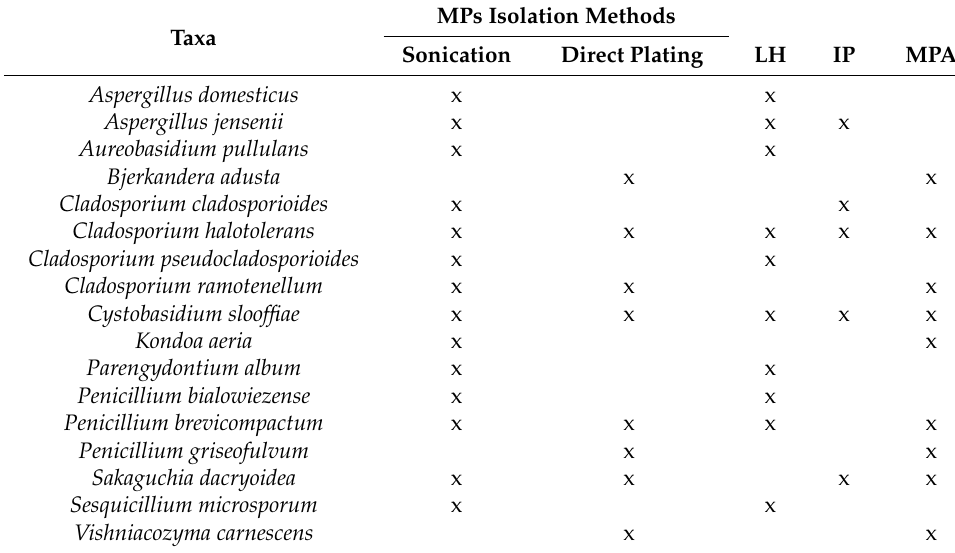
Table 2. Fungal taxa isolated from MPs at Livorno harbor (LH), intermediate point (IP), and marine protected area (MPA), with different isolation methods: sonication or direct plating.